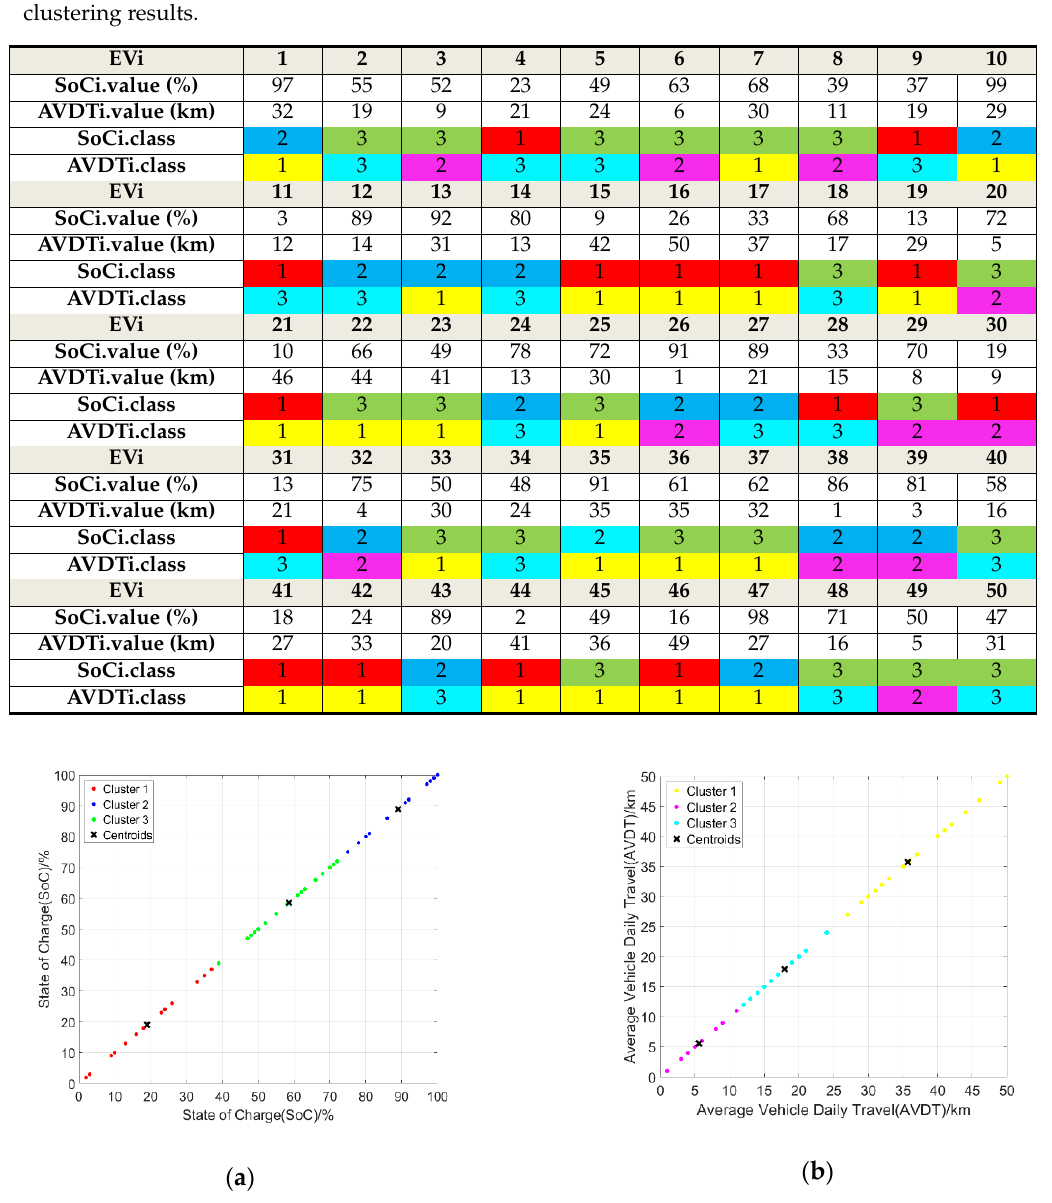
Table 1. Random models of SoC and average vehicle daily travel (AVDT) of 50 EVs and their clustering results.